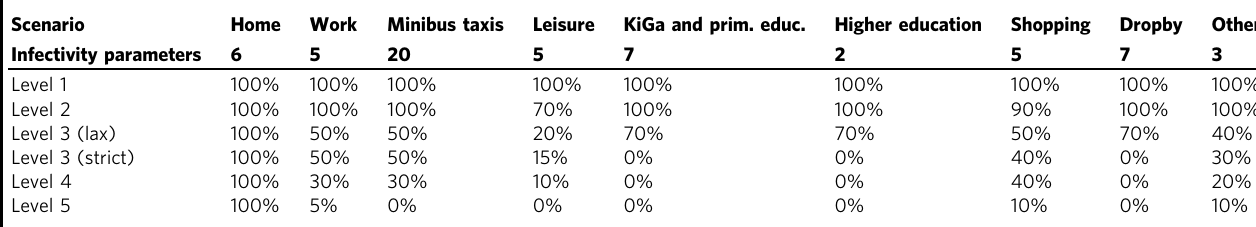
Table 3 Activity parameters that de fi ne the remaining share of each simulated activity relative to the period before the initial policy measures began.